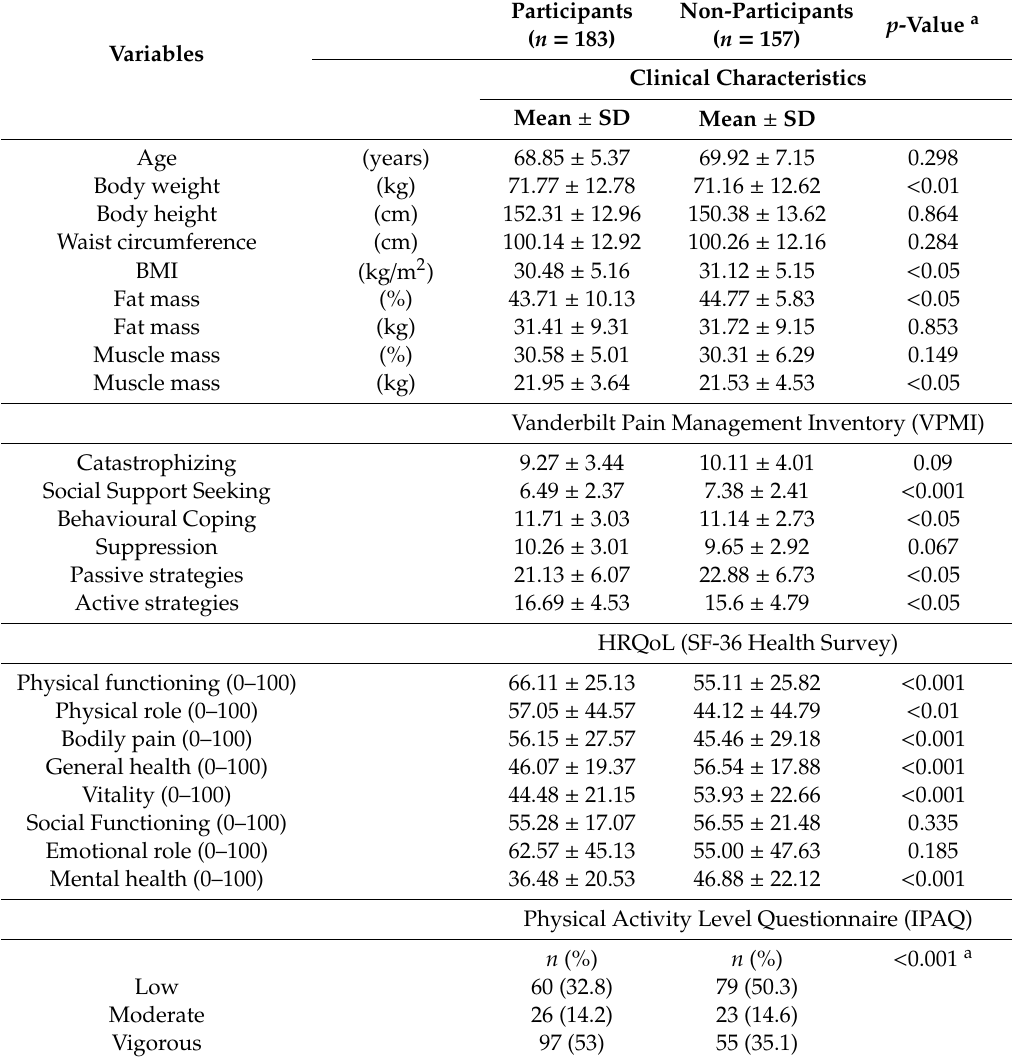
Table 1. Di ff erences of clinical characteristics, VPMI, HRQoL and IPAQ between non-participants and participants groups in a Pilates-aerobic